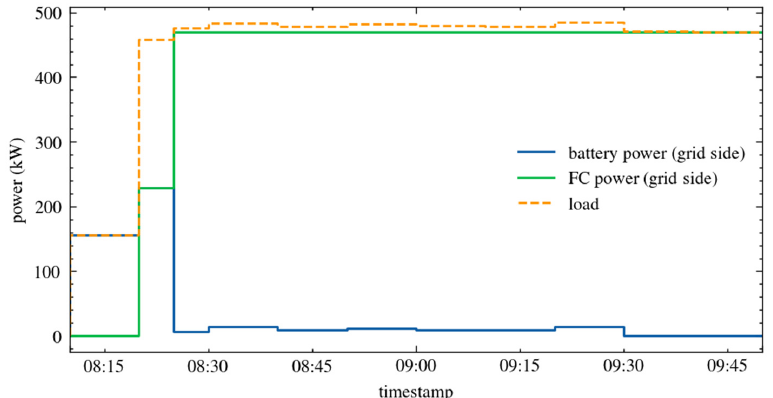
Figure 8. Grid-side powers during Scenario 1 (black